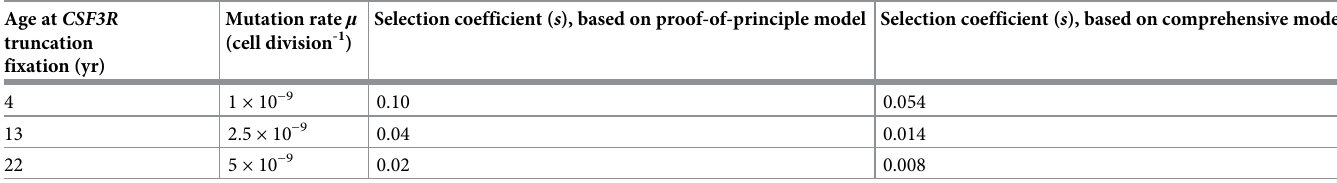
comprehensive models, with the corresponding mutation rates (rounded) corresponding to simulations underlying estimates in Table 1